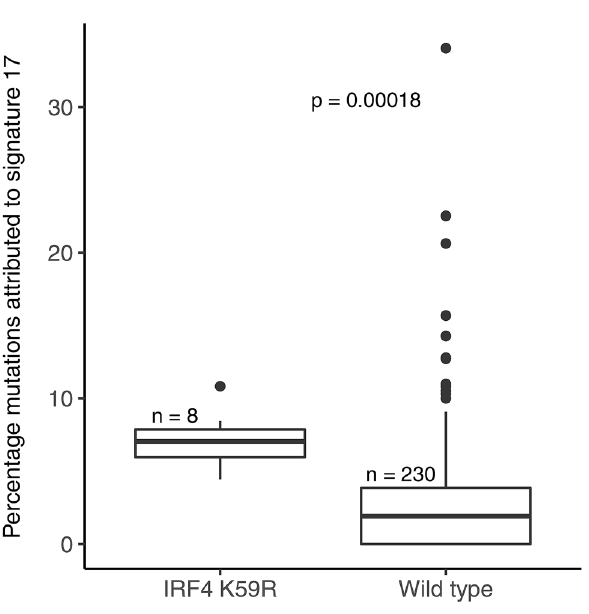
Figure 7. Patients with the IRF4 K59R mutation showed significantly greater contribution of signature 17 to their mutational catalogue. Wilcoxon rank sum test was used to compare the contribution of each signature between the groups mutant or WT for a given